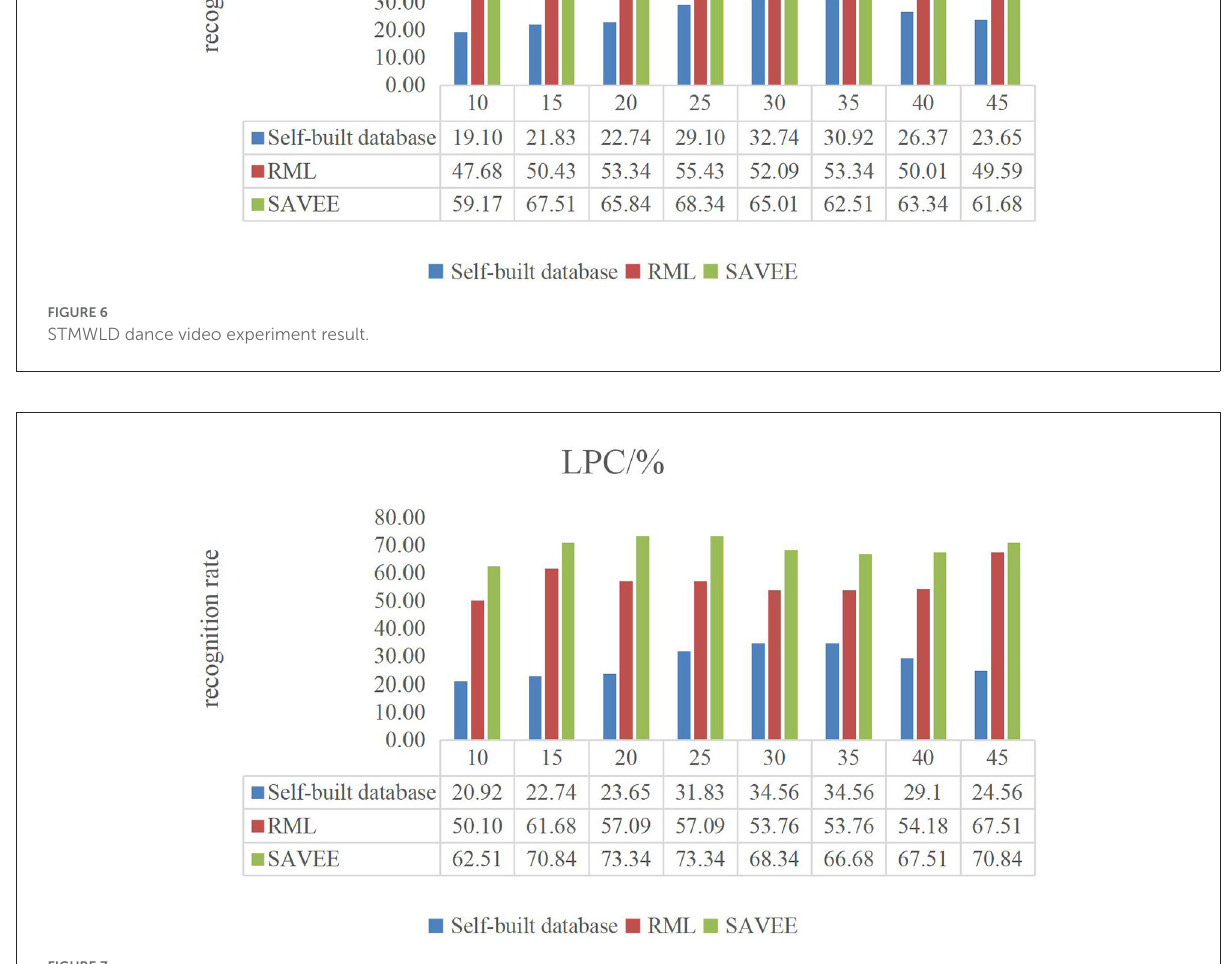
FIGURE7 LPC dance video experiment